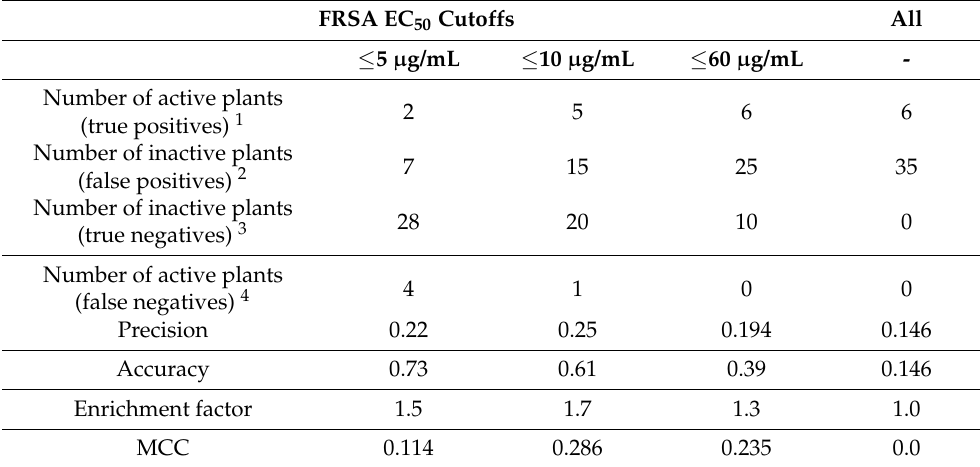
Table 3. EC 50 cutoffs for free radical scavenging activity